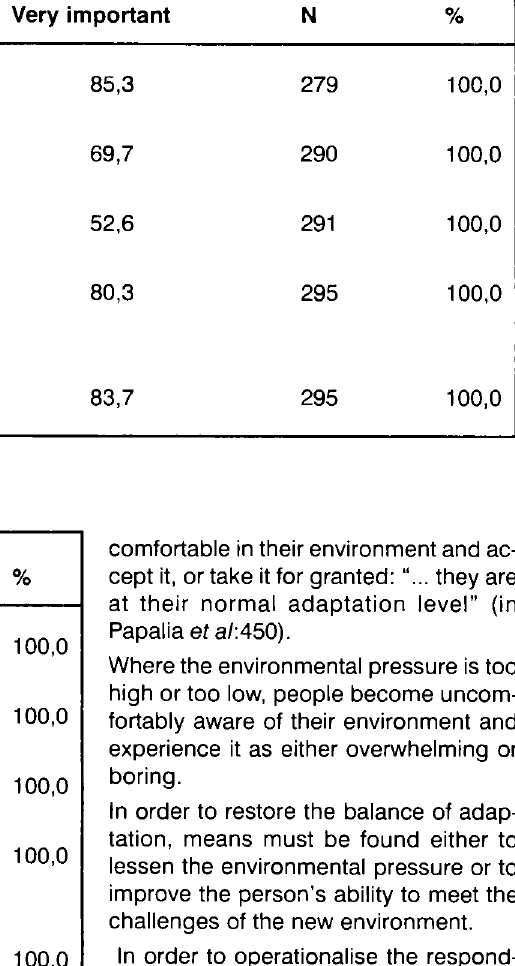
TABLE 5: Frequency of contact with significant others Contact